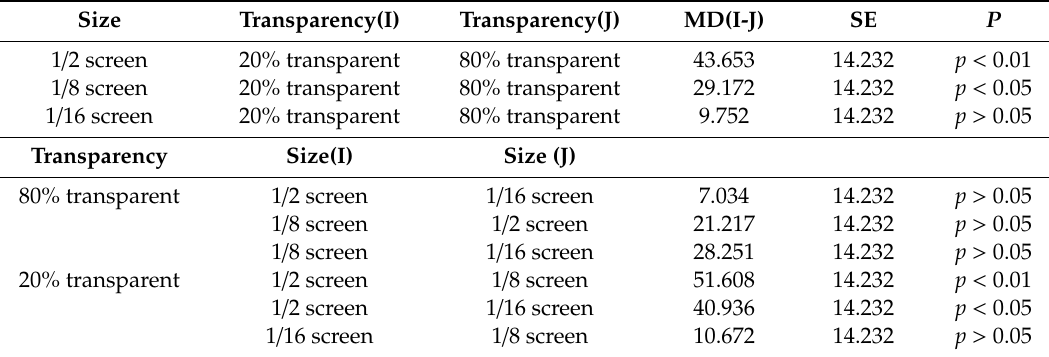
Table 4. Simple e ff ect of total task completion